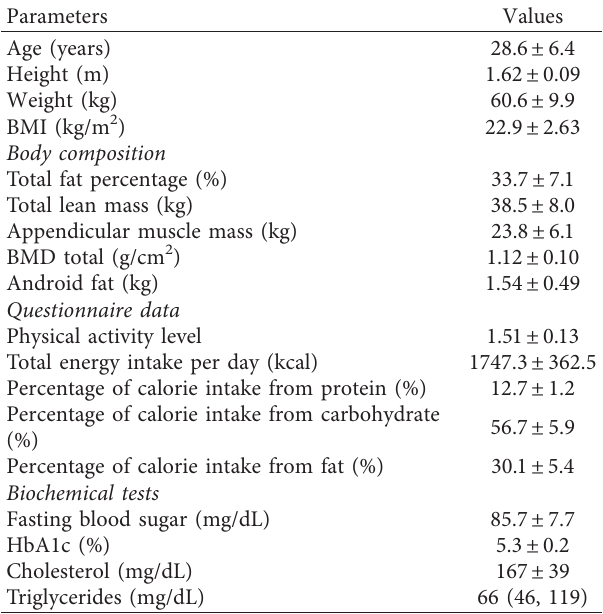
Table 1: Baseline characteristics of the study participants.